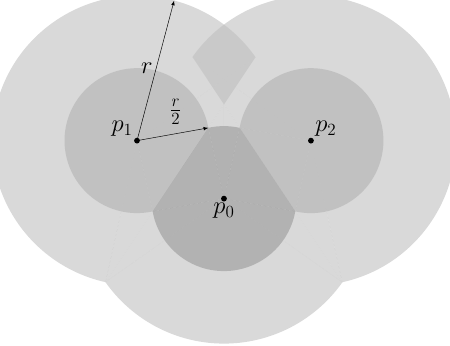
Figure 1. The comparison of the valid and invalid approximate Voronoi partition of three sensors with a limited sensing range r